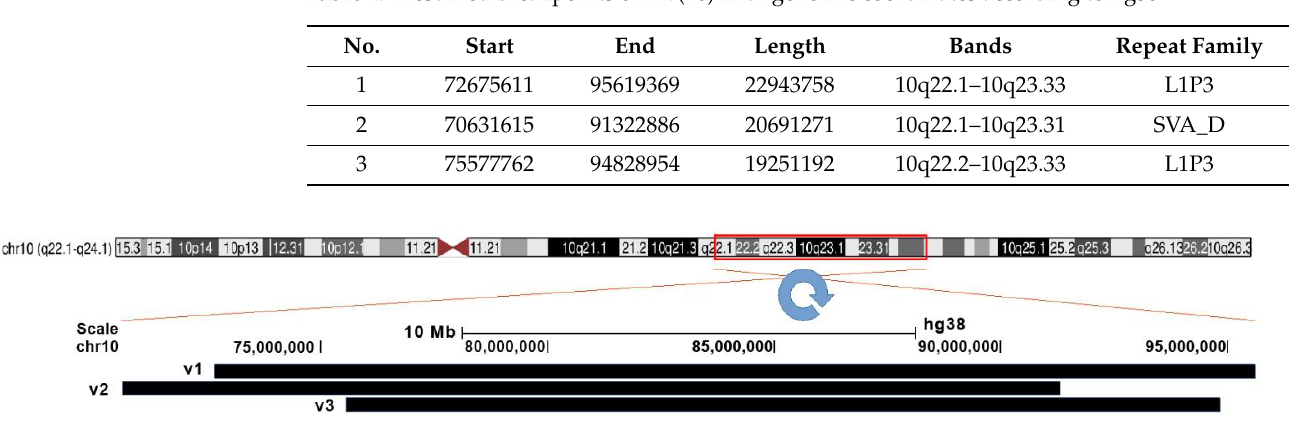
Table 1. Presumed breakpoints of inv(10) with genomic coordinates according to hg38.